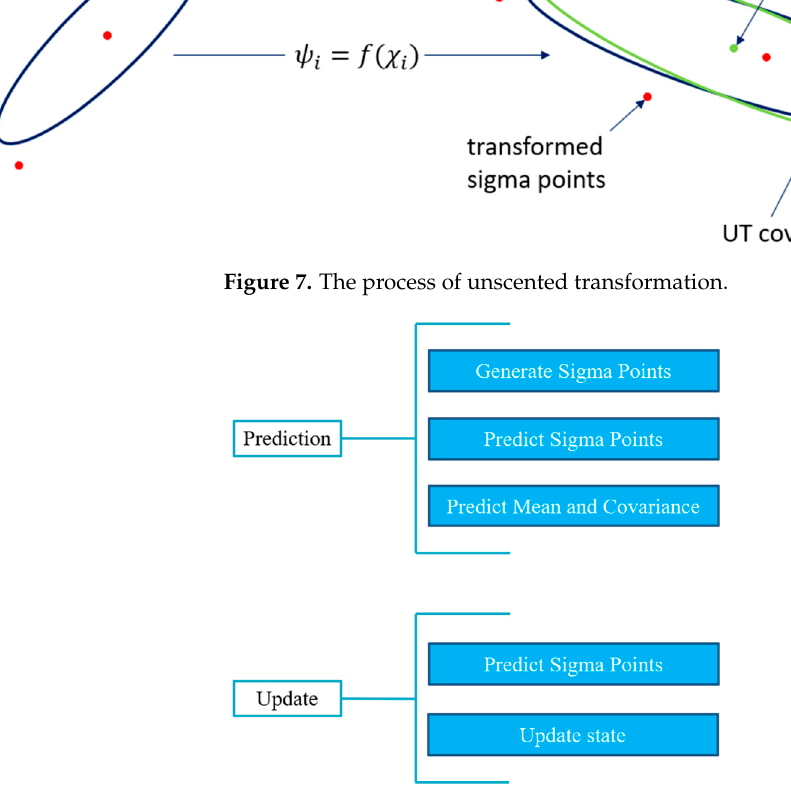
Figure 8. The process of unscented Kalman filter.